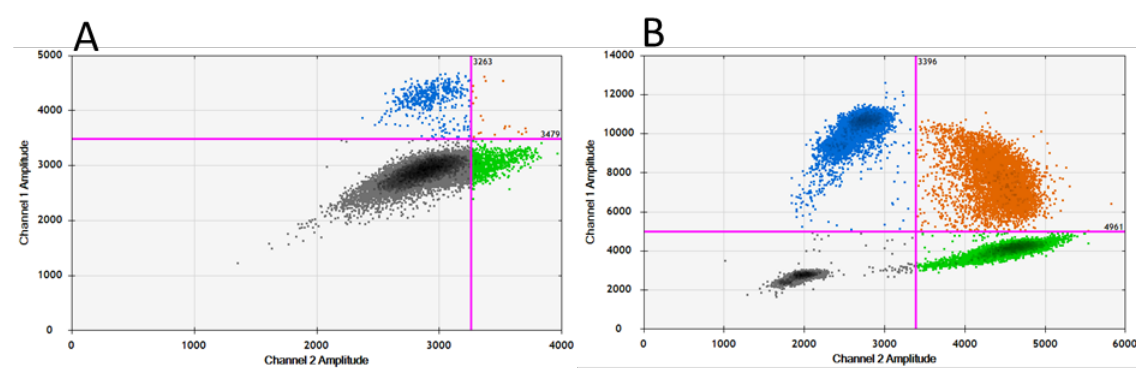
Figure 2. QuantaSoft 2D view of results before (A) and after (B) optimisation of quenchers and thermal gradient. The negative droplets are shown in black; droplets containing the FAM-labelled E119 wild type are blue and the HEX-labelled V119 mutant are green. Droplets containing both fluorescent probes are orange.